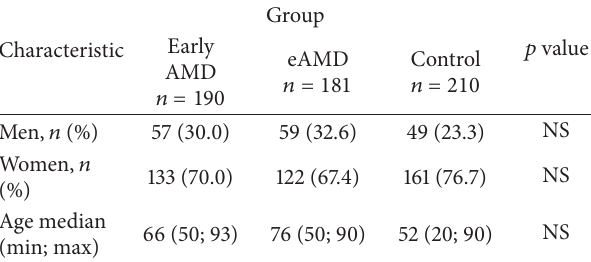
Table 1: Demographic characteristics of the study